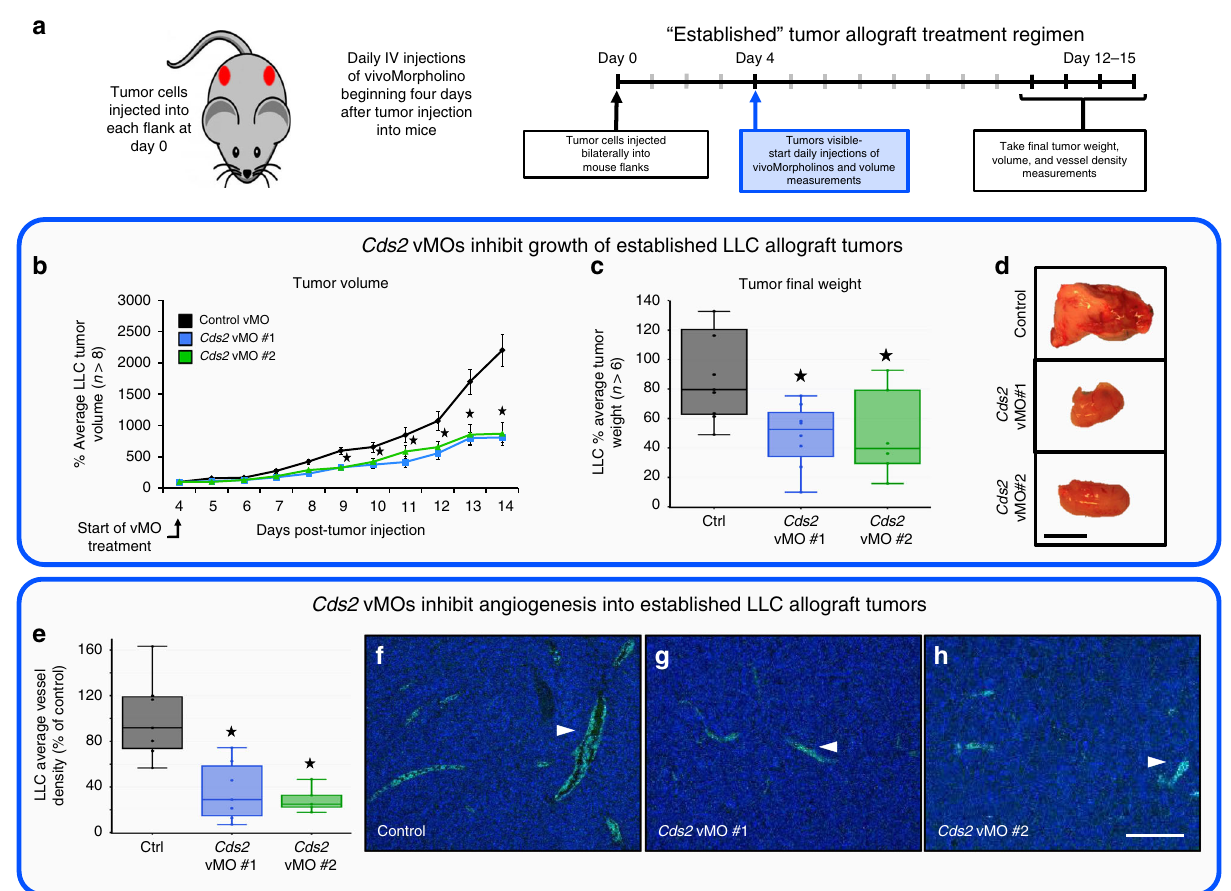
Fig. 5 Systemic Cds2 suppression inhibits growth of established tumors. a Schematic of established tumor allograft assay. Lewis Lung Carcinoma (LLC) tumor cells were injected into each fl ank of adult B6/C57 mice at day 0 and tumors allowed to develop for 12 – 15 days. Daily intravenous injections of control vivoMorpholino (vMO) or vMO targeting one of two independent sites in the Cds2 gene (vMO #1 and vMO #2) were started at day 4 after tumor implantation. Volume measurements were taken daily starting at day 4, when tumors became visible and vMO treatment started, with fi nal tumor volumes and weights taken at the termination of the experiment. b Quantitation of daily average tumor volume (in mm 3 ) of LLC tumors, normalized to the